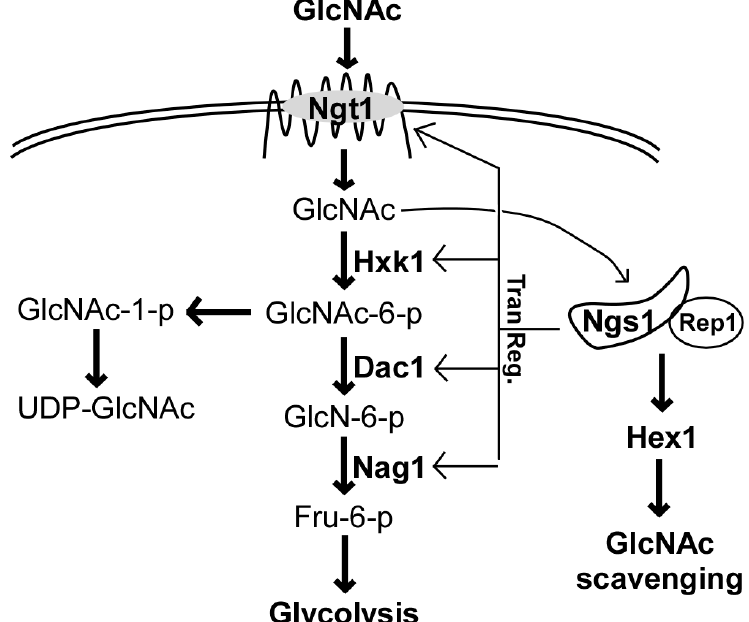
Figure 1. N-acetlyglucosamine (GlcNAc) catabolism in Candida albicans. Ngt1, GlcNAc-specific transporter; Hxk1, GlcNAc kinase; Dac1, GlcNAc-6-phosphate deacetylase; Nag1, Glucosamine-6-phosphate deaminase; Ngs1, N-acetyltransferase; Rep1, transcription factor involved in transcription of GlcNAc-inducible genes. GlcNAc is transported into the cytoplasm by the Ngt1 transporter and is catabolized to fructose-6-phosphate by Hxk1, Dac1, and Nag1. Ngs1 can bind to GlcNAc and may function as a putative sensor. Together with the transcription factor, Rep1, Ngs1 induces the